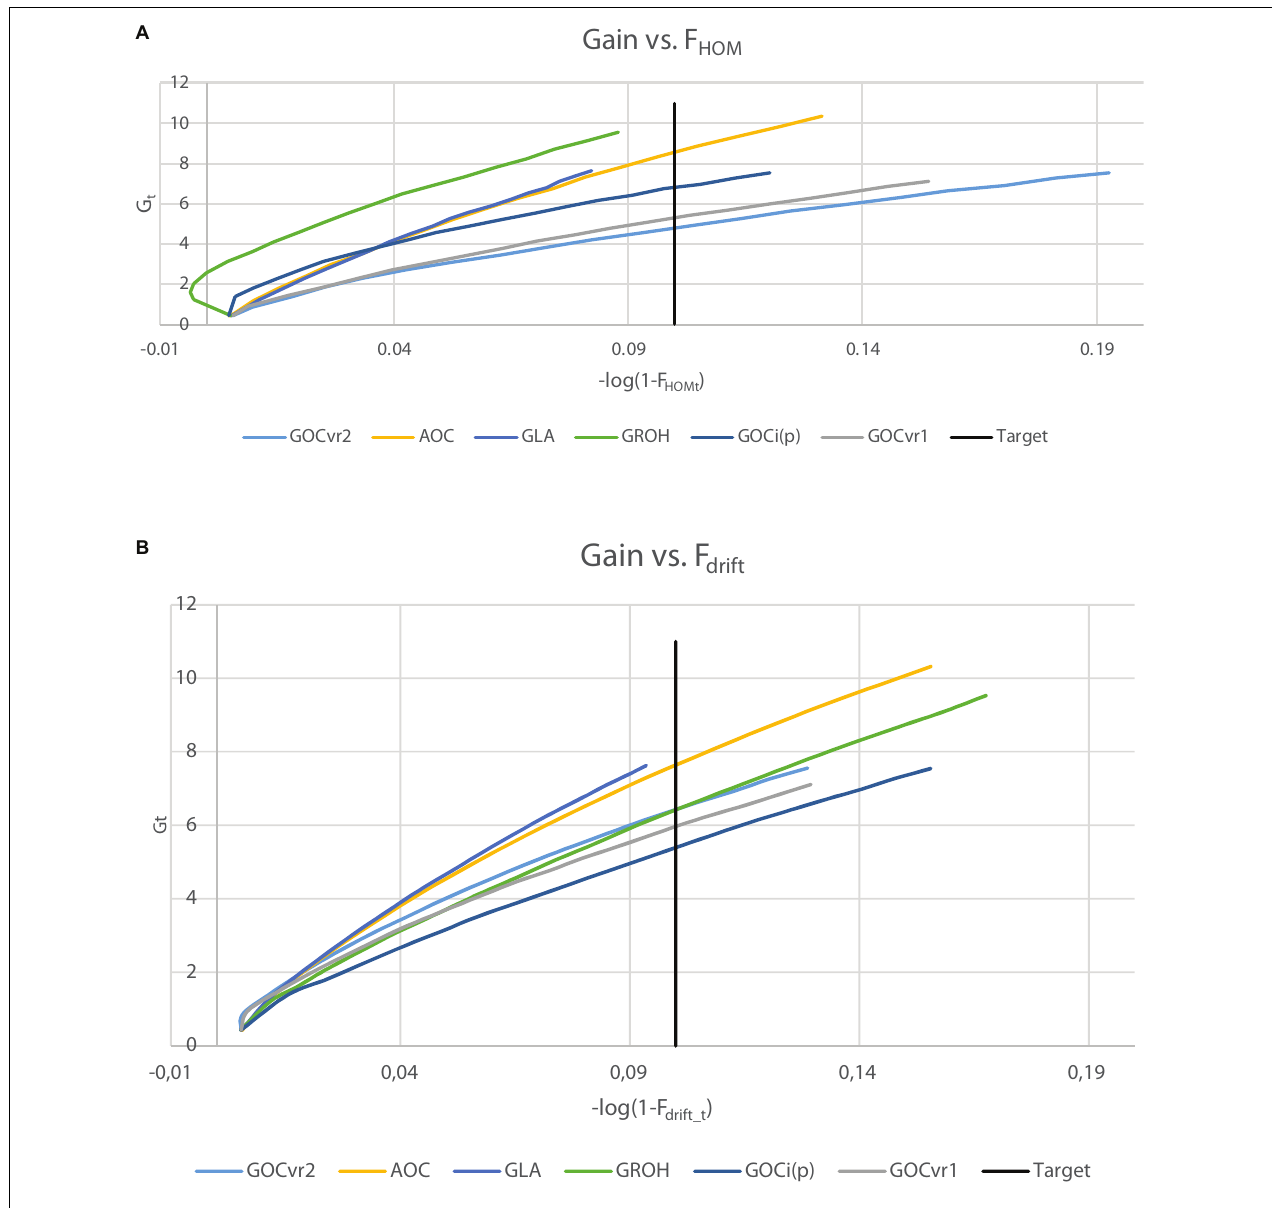
FIGURE 5 | Genetic gain, Gt plotted against inbreeding for generations 1–20, where inbreeding is transformed to a logarithmic scale by –log(1- F t ) for F hom (A) or F drift (B) . For (cid:49) F = 0.005, the target after 20 generations is shown (–log(1- F t ) =